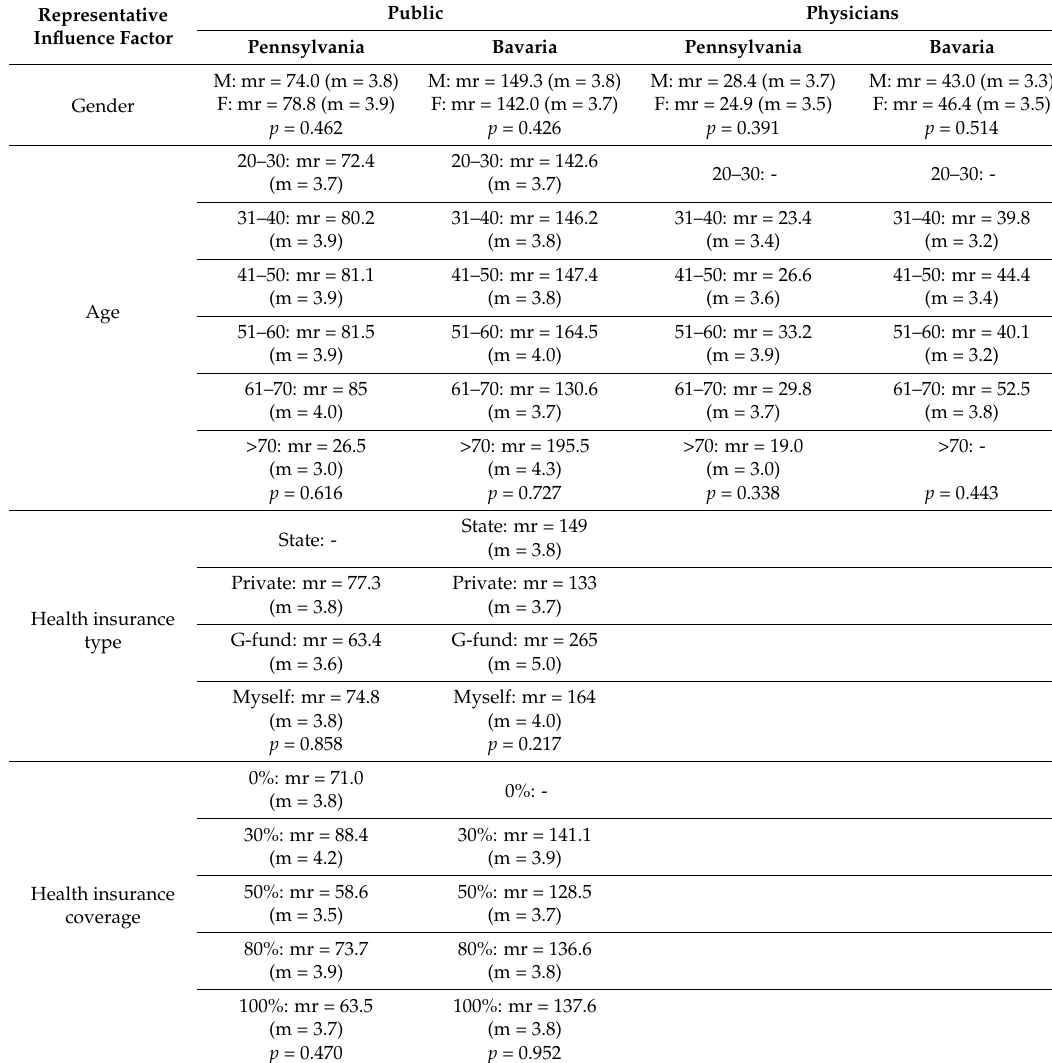
Table 4. Factors to Influence PM